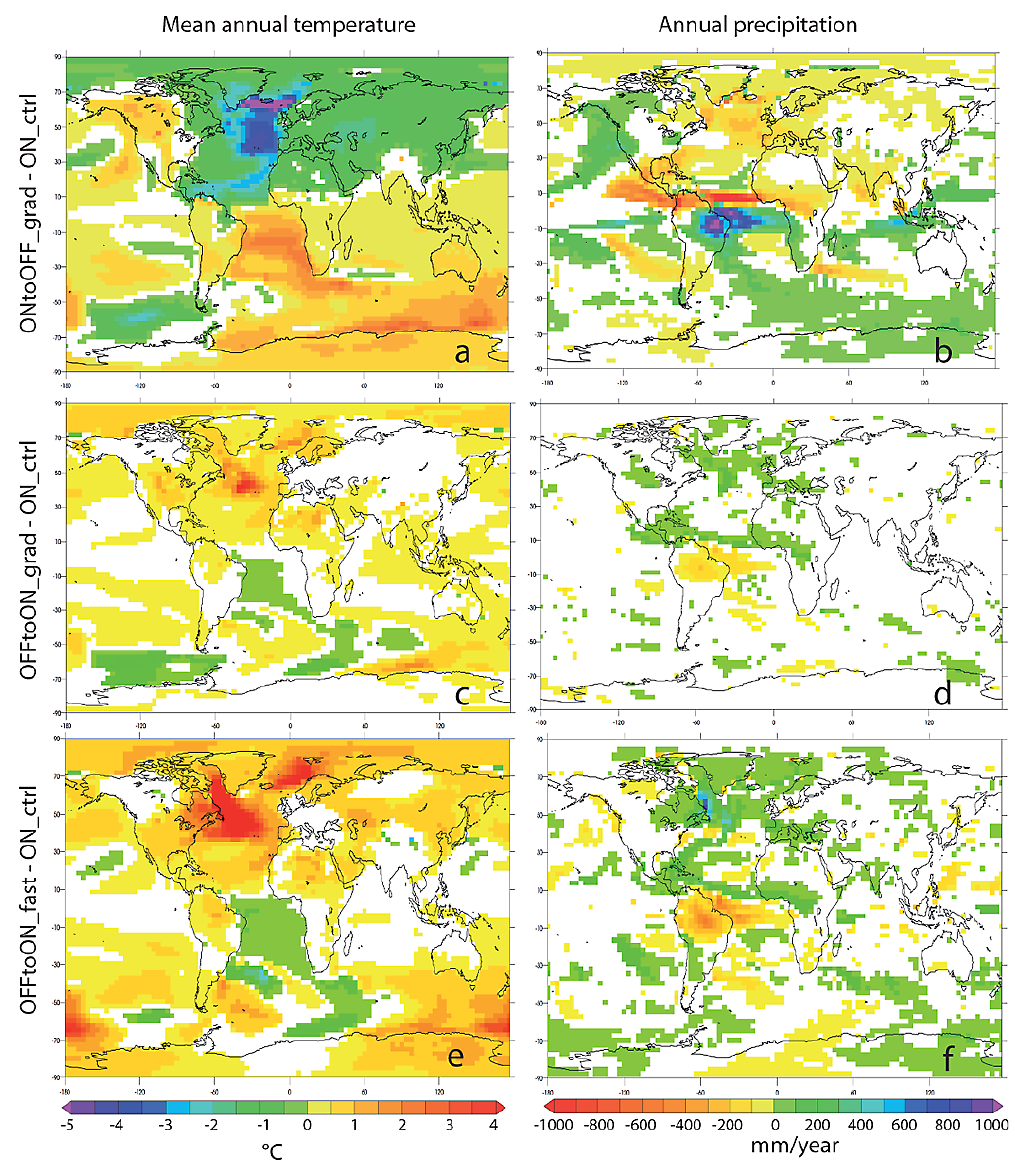
Fig. 2. L.h.s.: difference in mean annual surface temperature ( ◦ C). R.h.s.: difference in annual precipitation (mmyr − 1 ). Top: ONtoOFF grad– ON ctrl; middle: OFFtoON grad–ON ctrl; bottom: OFFtoON fast–ON ctrl. White areas are regions were differences are not significant at the 95% level. ON ctrl: average over years 201–250; ONtoOFF grad: average over years 401–450; OFFtoON grad: average over the last 30yr of the run; OFFtoON fast: average over the last 20yr of the